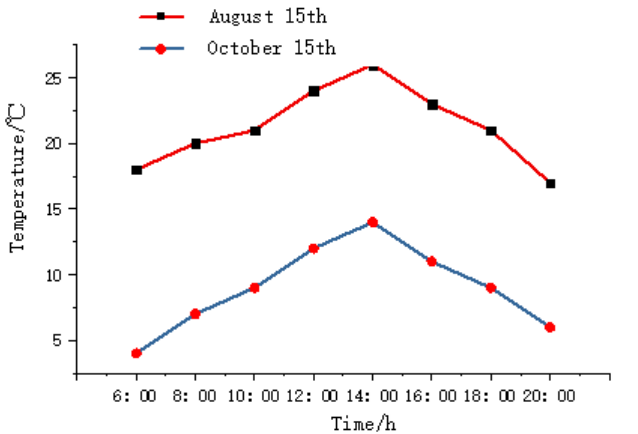
Figure 3. The temperature change curve of a certain day in summer and autumn in the experimental area.